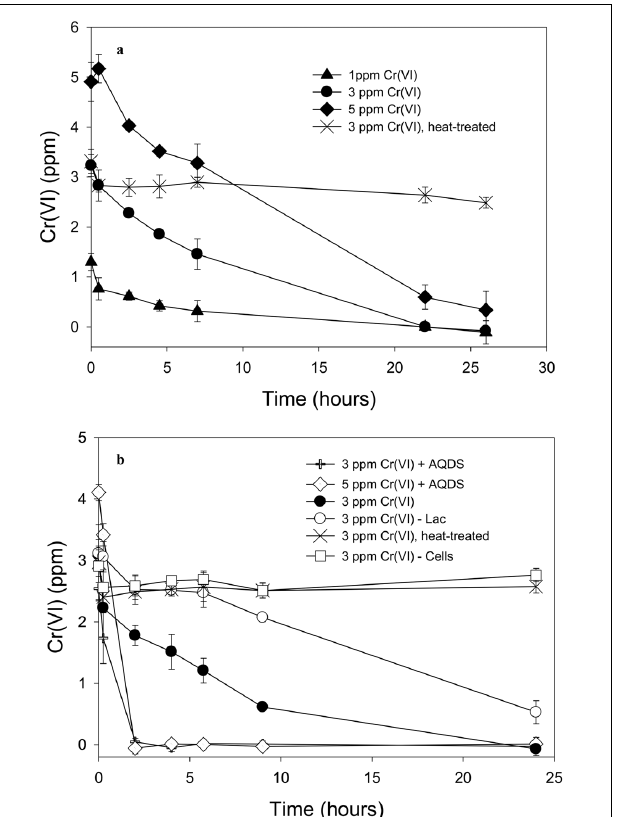
FIGURE 4 | (A) Removal of 1, 3, and 5 ppm Cr(VI) by “ P. lilae ” UFO1. Lactate (10 mM) was present in all treatments. (B) Cr(VI) removal in the presence or absence of 1 mM AQDS, and removal of Cr(VI) in lactate-free controls. Lactate (10 mM) was present in all treatments unless otherwise noted. Symbols are means of triplicate analyses, and error bars indicate ± 1 standard